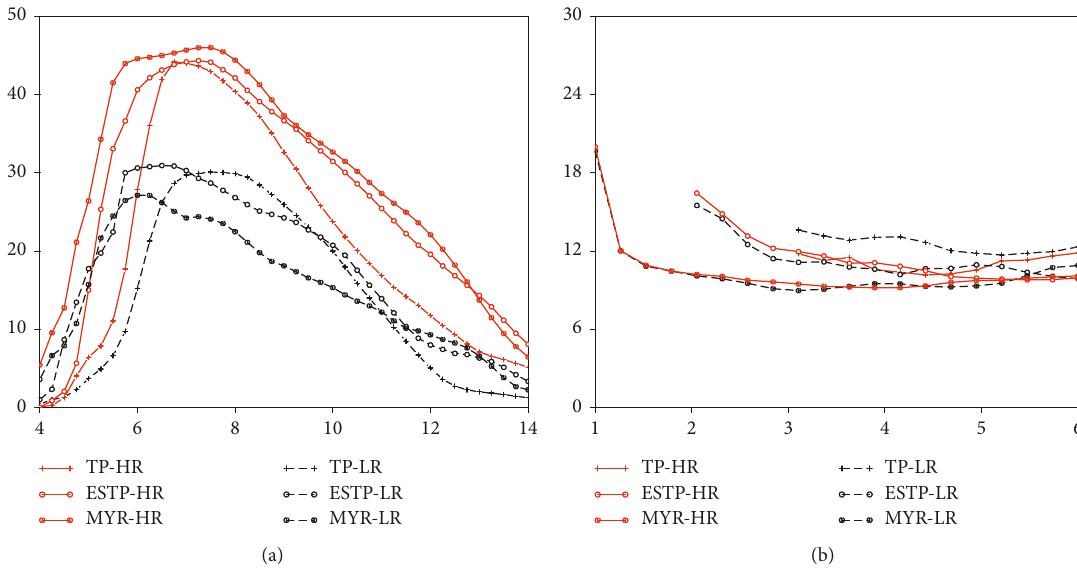
Figure 9: The vertical distribution of the average effective radius of different hydrometer particles corresponding to different types of TPV category cloud clusters in each key region: (a) effective radius of ice crystal particles; (b) effective radius of water-droplet particles ((a) ice crystals, (b) cloud droplets, red legend represents heavy rainfall type, the black legend represents light rainfall type, X -axis represents altitude (unit: km), and Y -axis represents average effective radius (unit: μ